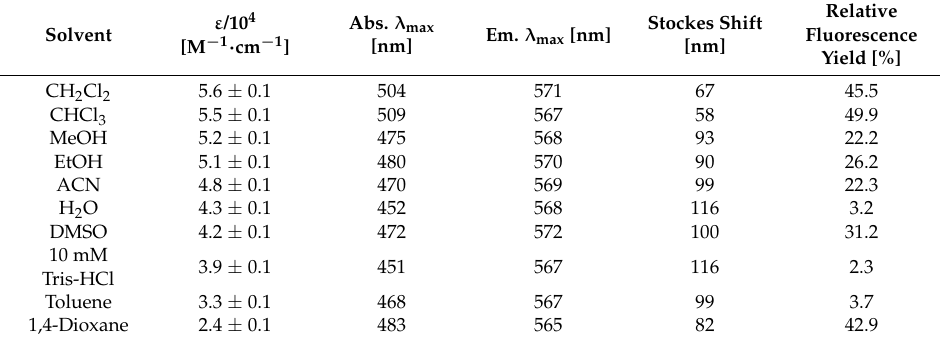
Figure 1. ( A ) Absorption spectra ([ 3c ] = 2.9 × 10 − 5 M) and ( B ) fluorescence spectra ([ 3c ] = 4.4 × 10 − 6 M) of the dye 3c in selected organic solvents and aqueous solutions at room temperature ( λ ex = Abs. λ max ). Table 2. Effect of solvent on the spectral parameters in the absorption and fluorescence spectra of ligand 3c (mean values ± SD of three determinations).